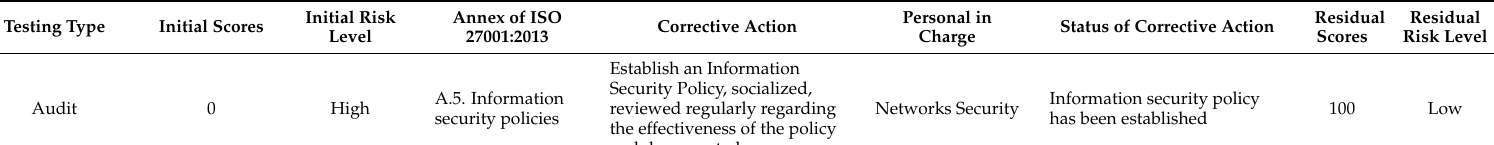
Table 7. An example of the findings and verifications from an improved network security